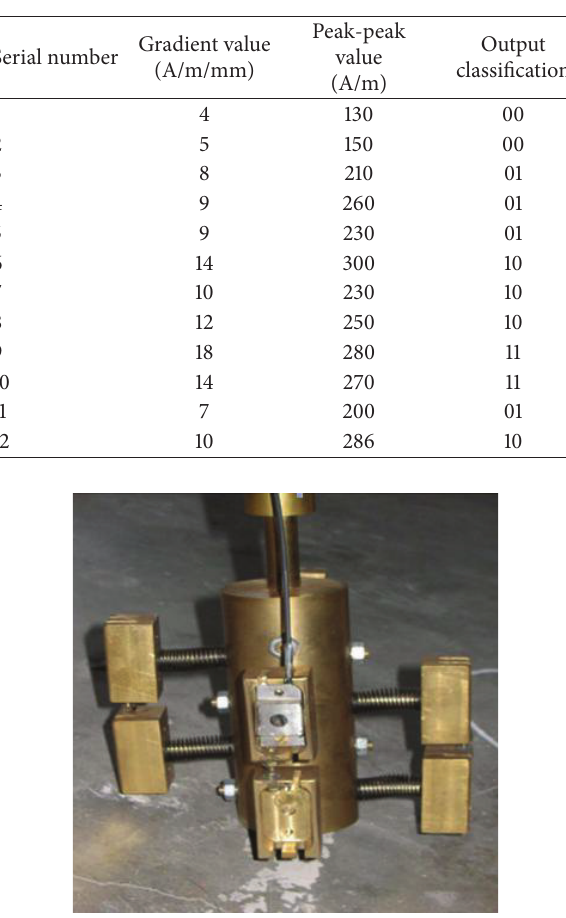
Table 1: Quantitative evaluation on danger level for oil well casing.